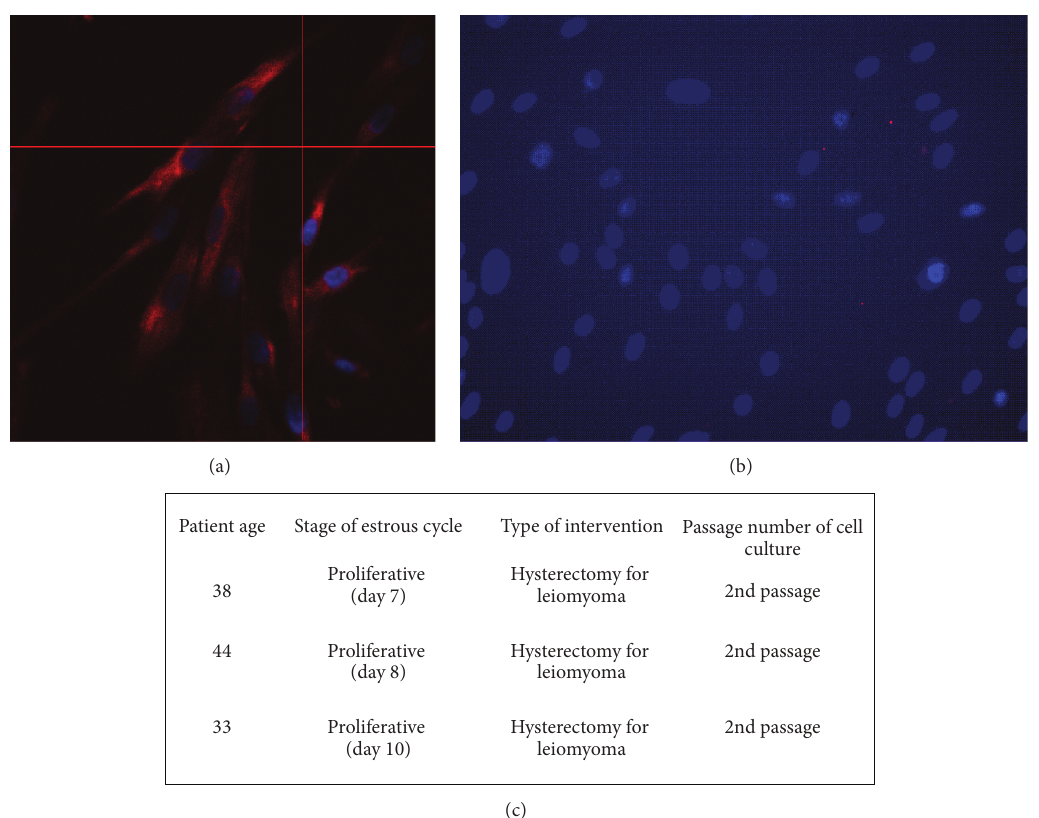
Figure 1: Characterization of human endometrial stromal cells by immunofluorescence. (a) Cells were stained with anti-vimentin antibody (red staining). Nuclei were stained with DAPI (blue staining). (b) Cells were negative for staining with anti-cytokeratin antibody. Only the nuclei, stained with DAPI (blue), were visible. Scale bar = 50 𝜇 m. (c) Table showing the information about the origin of the endometrial specimens used in the